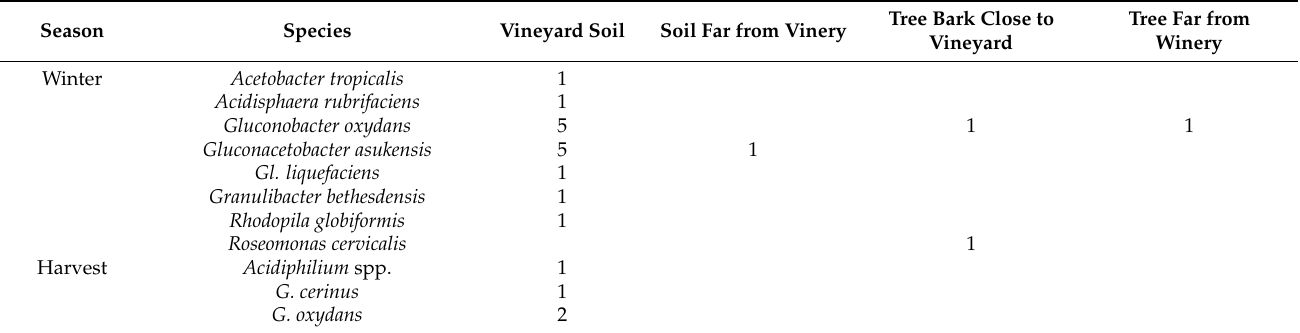
Table 4. Number of samples with acetic acid bacteria isolates recovered from vineyard environment samples throughout the